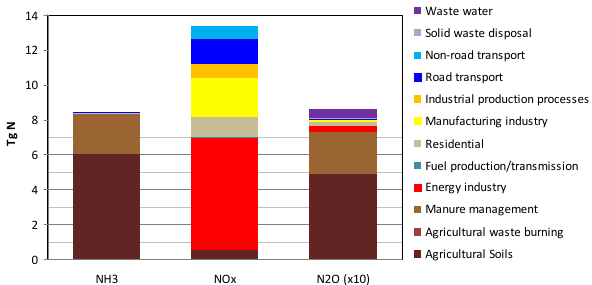
Emissions of NH 3 , NO x and N 2 O (expressed in Tg N) for the People’s Republic of China in 2005 according to the EDGAR v4 inventory (EDGAR, 2009) for the main emitting source sectors. N 2 O emissions are increased by a factor of 10 for ease of